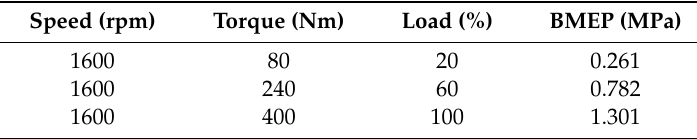
Table 3. Engine operating